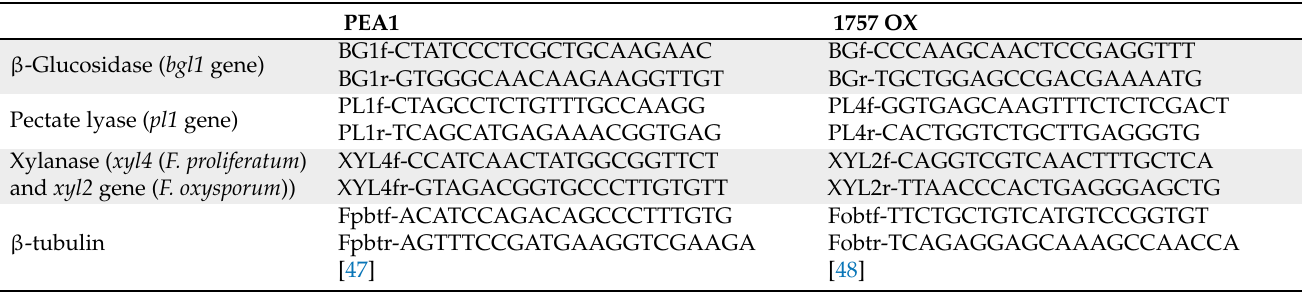
Table 2. List of primers used in the